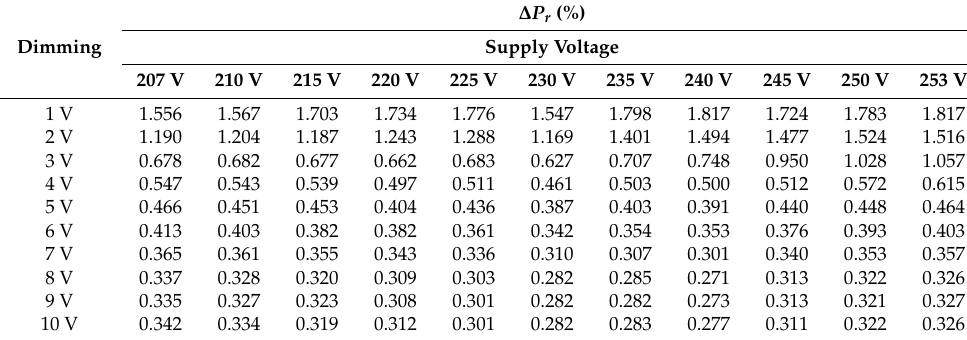
∆ P r (%) Supply Voltage